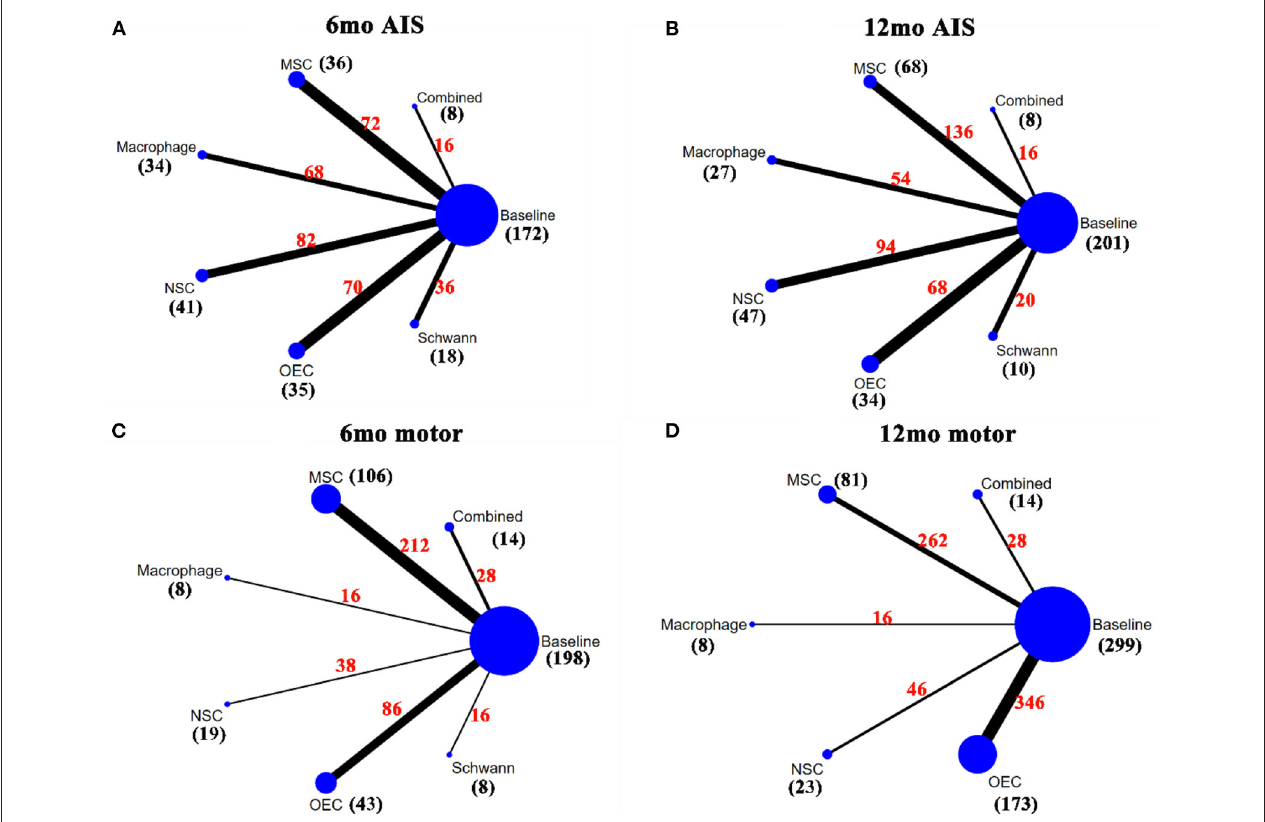
FIGURE 2 | Network plots for AIS grade and motor. (A) A network plot for 6mo AIS grade; (B) A network plot for 12mo AIS grade; (C) A network plot for 6mo ASIA motor score; (D) A network plot for 12mo ASIA motor score. The nodes represent different interventions, the size of the nodes represents the sample size of that intervention, and the thickness of the lines connecting the nodes represents the sample size involving both interventions. The black number represents the sample size of the intervention, and the red number represents the total sample size of the two connected interventions. AIS grade, American Spinal Cord Injury Association (ASIA) Impairment Scale; mo, month; MSC, mesenchymal stem cell; NSC, neural stem cell/neural progenitor cell; OEC, olfactory ensheathing